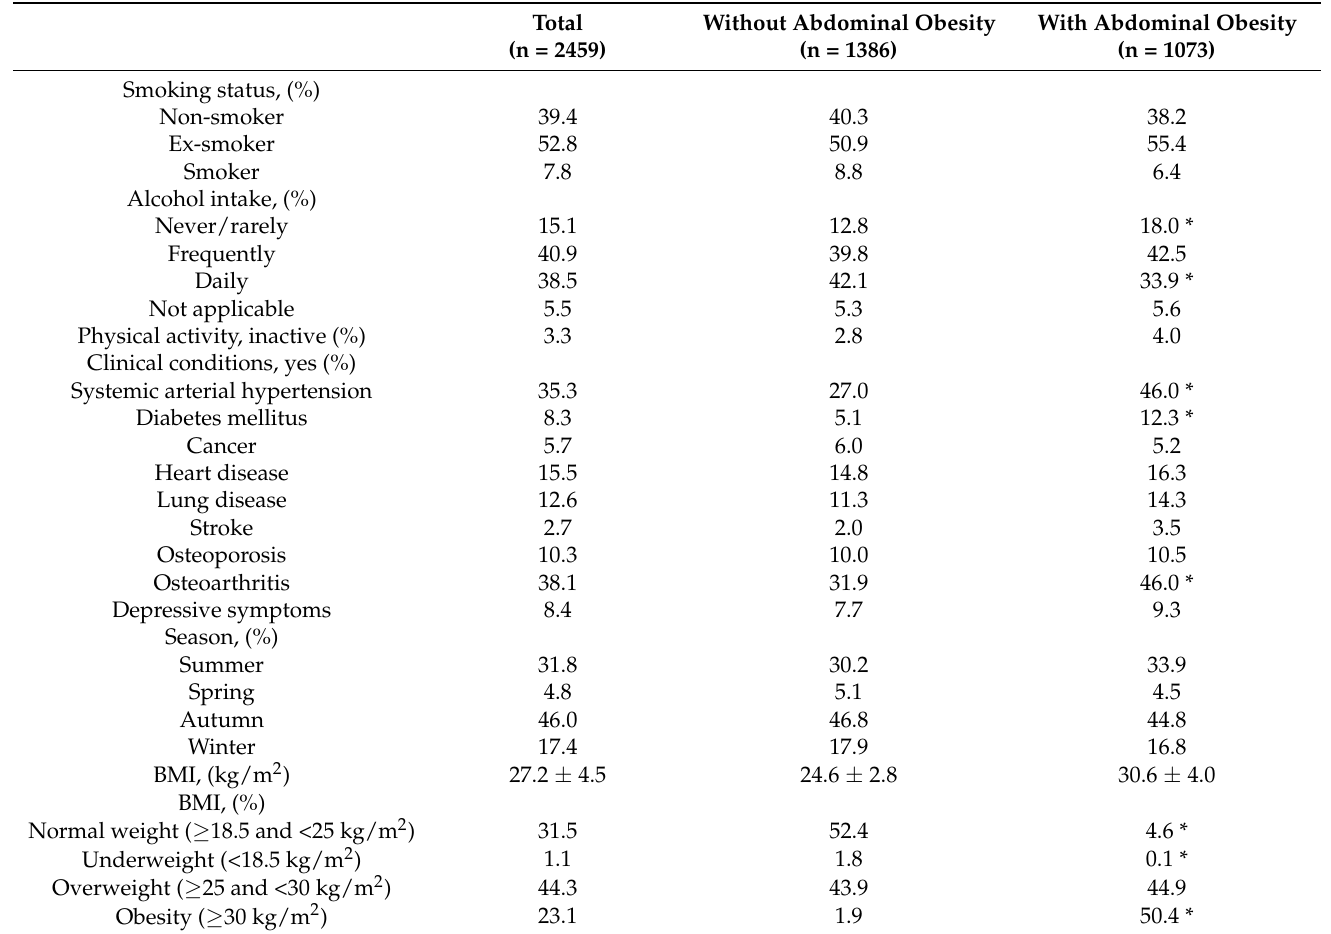
Table 2. Lifestyle habits, clinical conditions, and biochemical measures of 2459 individuals at baseline, ELSA Study